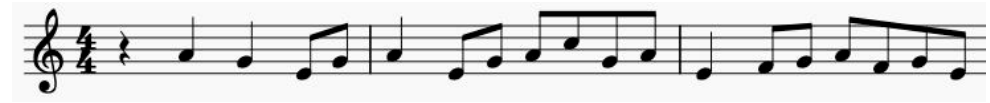
Figure 7. Leadsheets of the generated melody sequence.